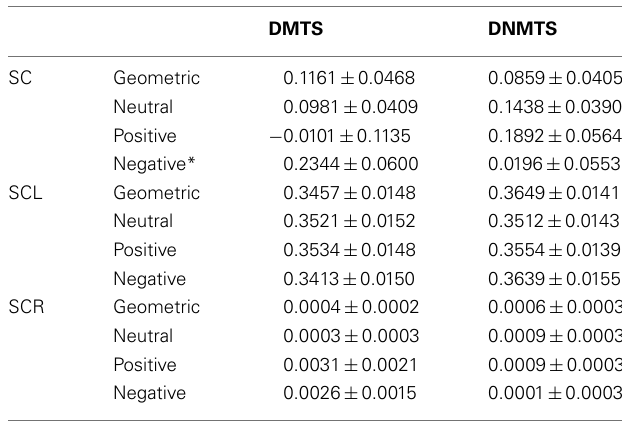
Table 4 | Mean ± SEM of GSR values according to task condition and sample